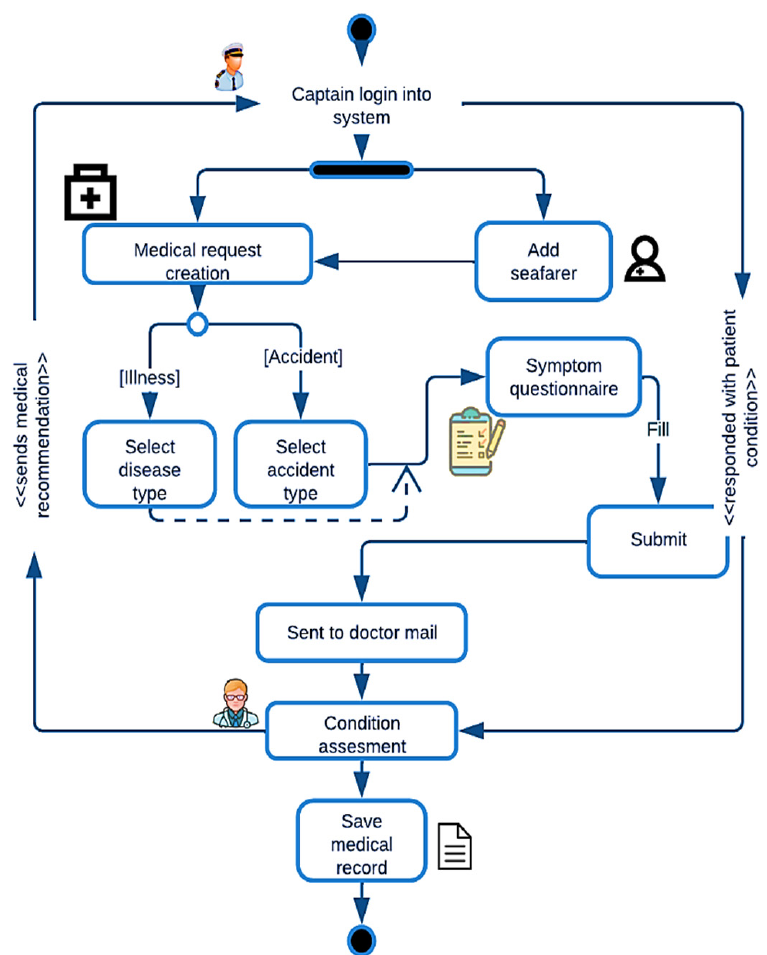
Figure 1. M Doc activity